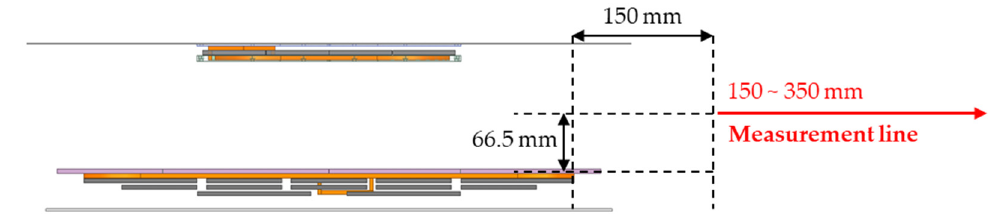
Figure 14. Leakage magnetic field measurement line for numerical comparison.